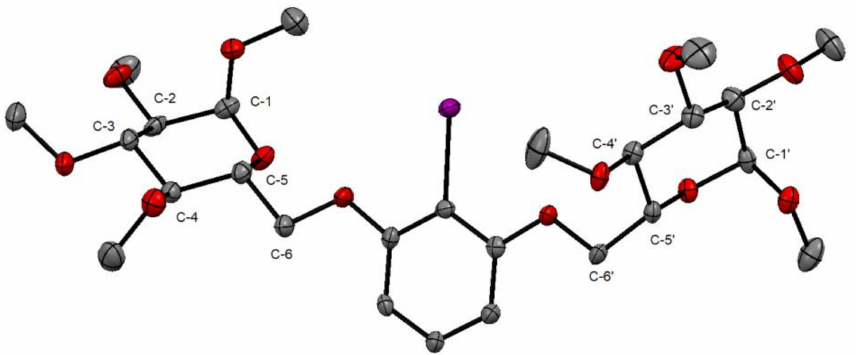
Figure 2. Molecular structure of 8c . Ellipsoids are given at the 50% probability level; hydrogens are omitted for better clarity. Grey: carbon, red: oxygen, purple: